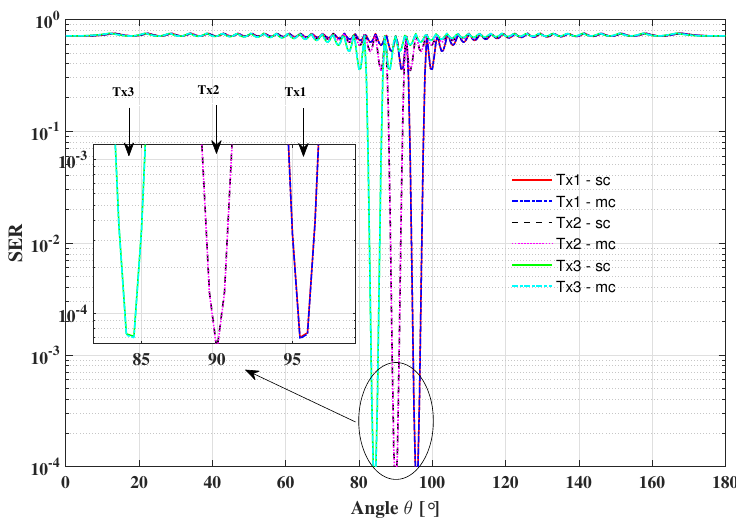
Figure 9. SER performance versus azimuth angle for the proposed DM schemes, where β 1 = 0.9 and ( E ) = 10 10log b / N 0 10